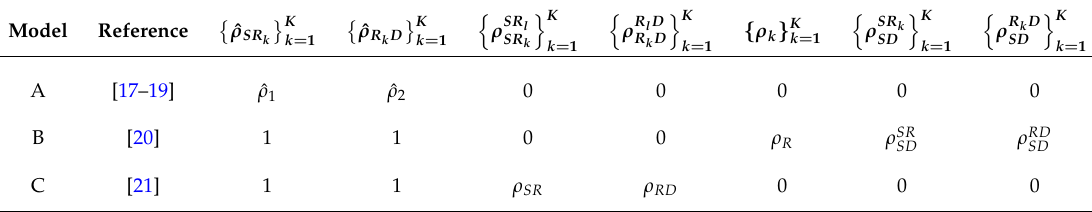
Table 2. A summary of channel correlation forms which have been